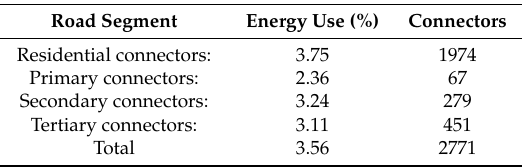
Table 3. Energy use ratio by road segment.